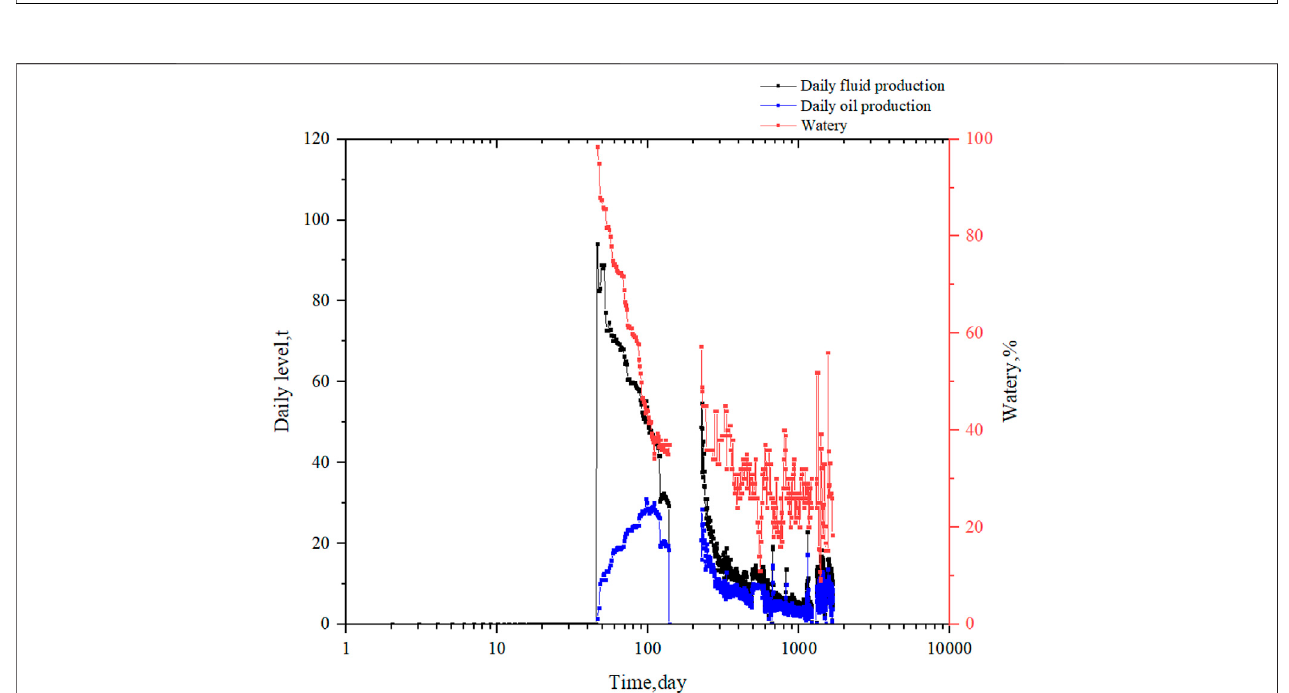
FIGURE 7 | Production performance curve of Well